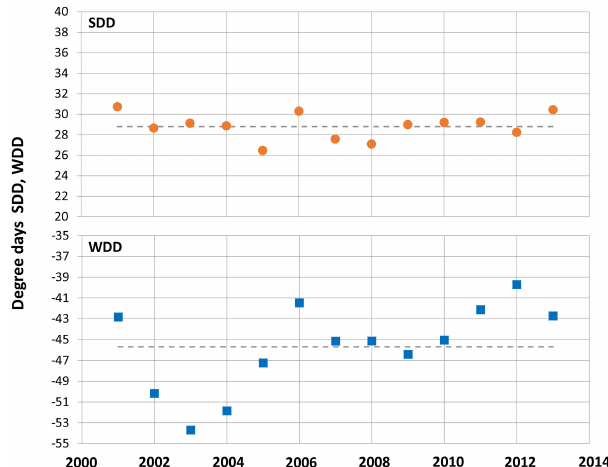
Figure 7. Summer degree days (SDD, circles) and winter degree days (WDD, squares) as an indicator for the thermal conditions at the ground surface over the course of the study period. The dashed lines indicate the respective means over the time